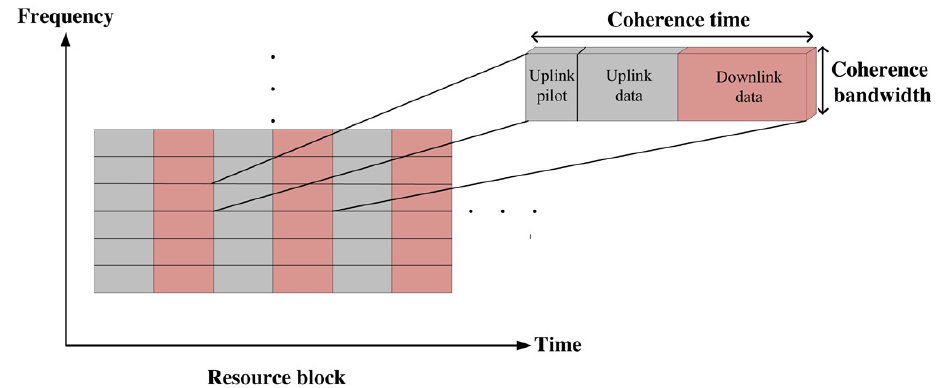
Figure 1. The resource block in time and frequency. The channel is assumed to be frequency flat over a specified period, which corresponds to the coherence time T . The pilot symbols T tr are used in each coherence block for the uplink channel estimation in the TDD system and the rest of the resources are used for uplink and downlink data